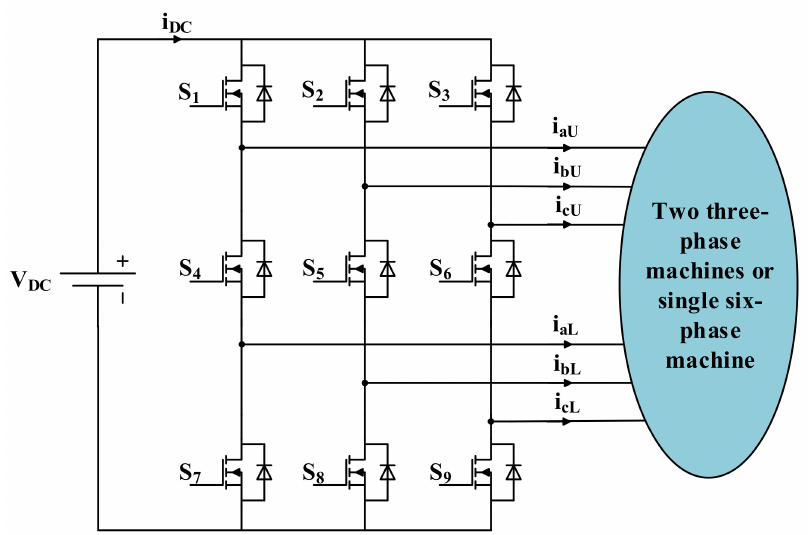
Figure 1. Nine-switch inverter-based electrification system. Thus, short-circuiting of the dc bus is prevented while the current continuity of the inductive loads is guaranteed. So, there are three possible switching states for each leg and a total of 27 allowed switching states for NSI, as listed in Table 1. According to Table 1, the switching states of NSI can be divided into three groups. While Group I is the group with zero vectors for both load stages, Group II has zero vectors for one of the loads and active vectors for the other, while Group III consists of active vectors for both loads [9]. Table 1. NSI Switching